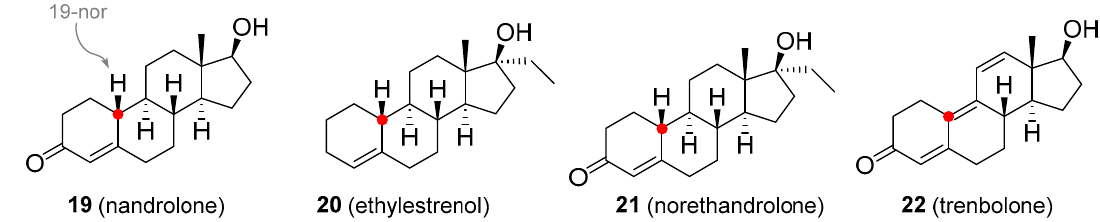
Figure 4. Nandrolone based analogues with a strong pro-estrogenic effect.